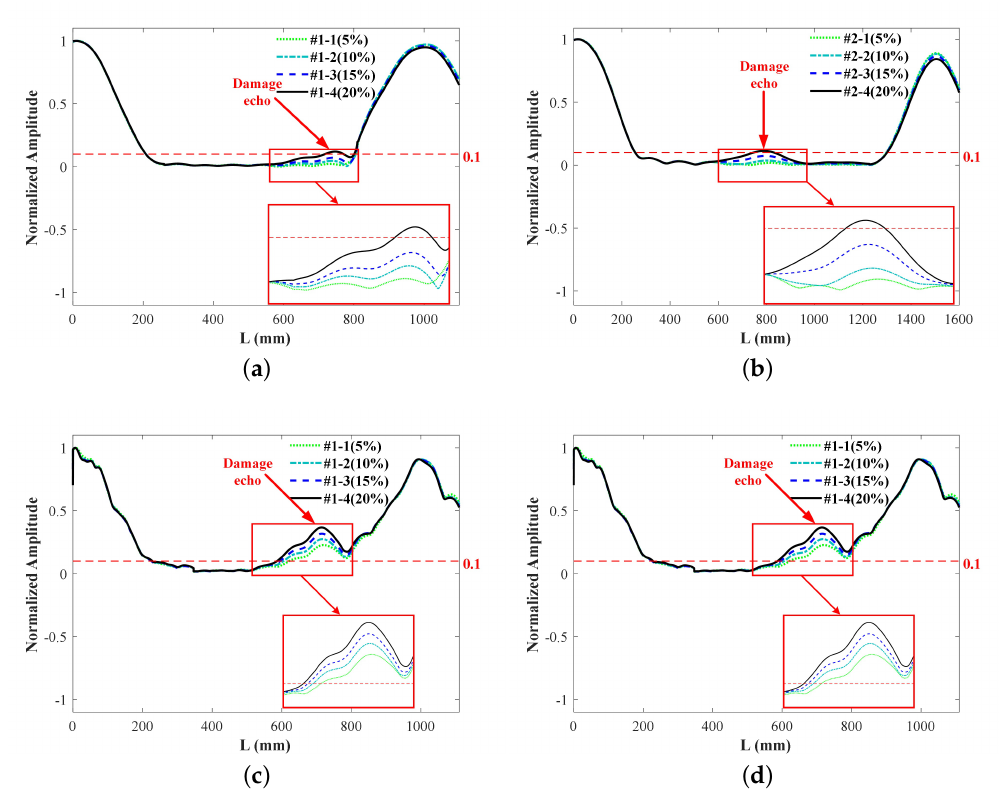
Figure 18. Experimental damage signals of different notches: ( a ) #1 25 kHz, ( b ) #2 25 kHz, ( c ) #1 SoM, ( d ) #2